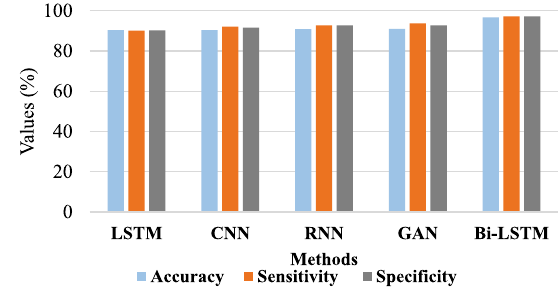
Fig. 13 Comparison of deep learning methods on NWPU dataset